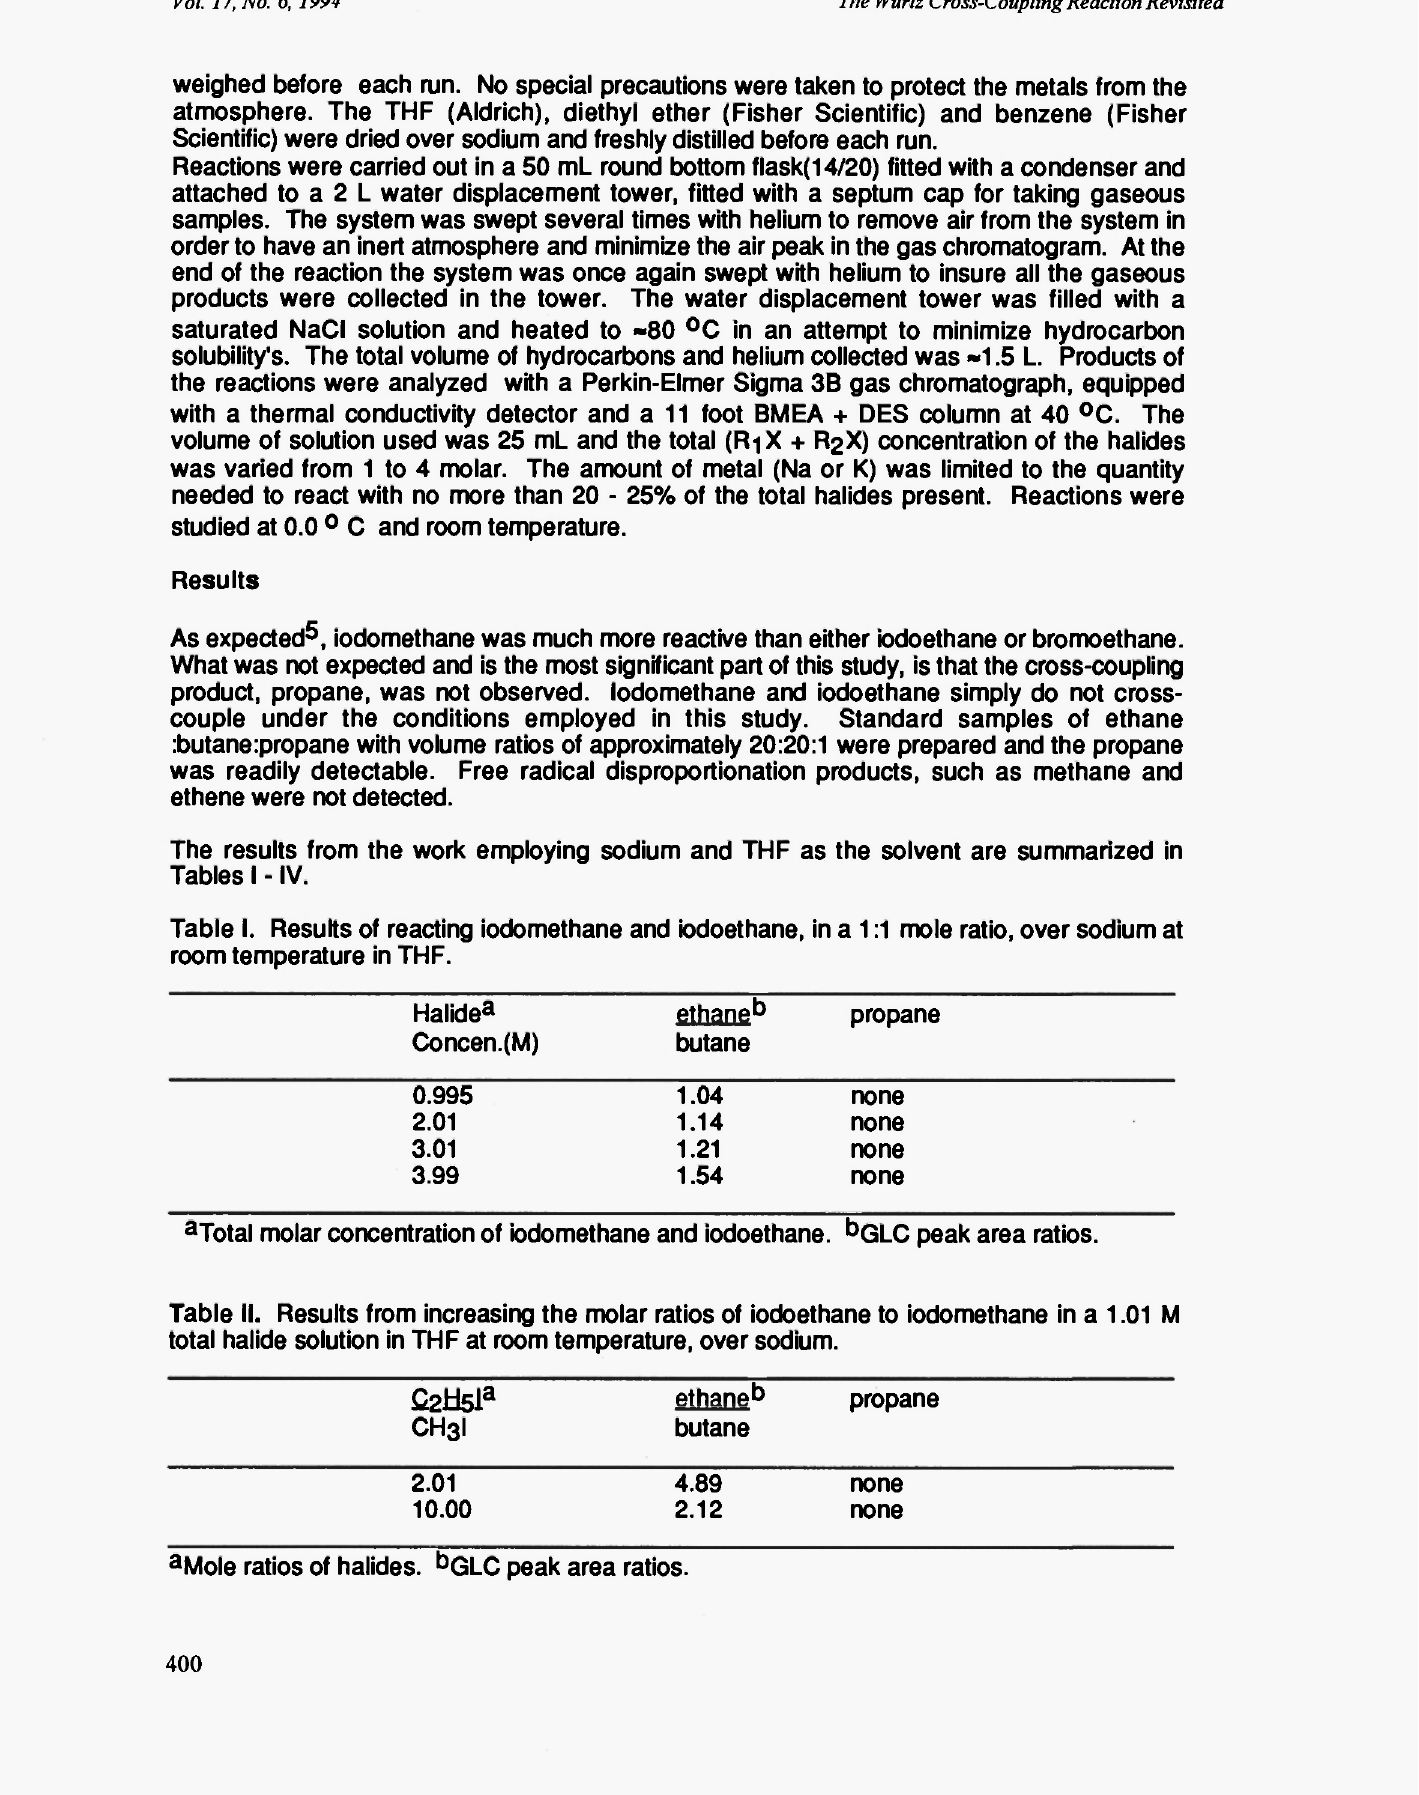
Table II. Results from increasing the molar ratios of iodoethane to iodomethane in a 1.01 Μ total halide solution in THF at room temperature, over